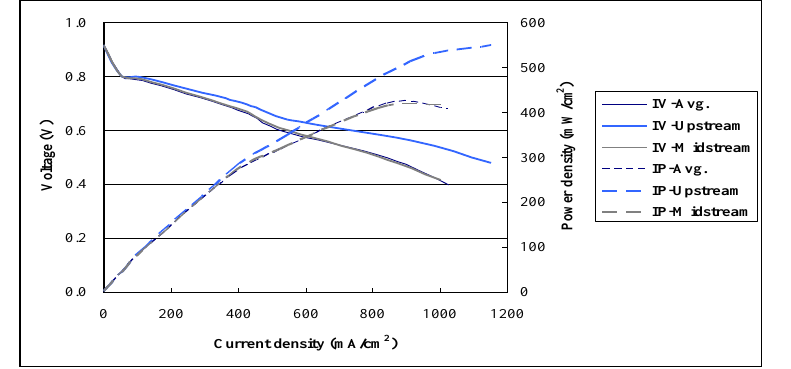
Figure 16. Comparison of cell performance with and without sensors.